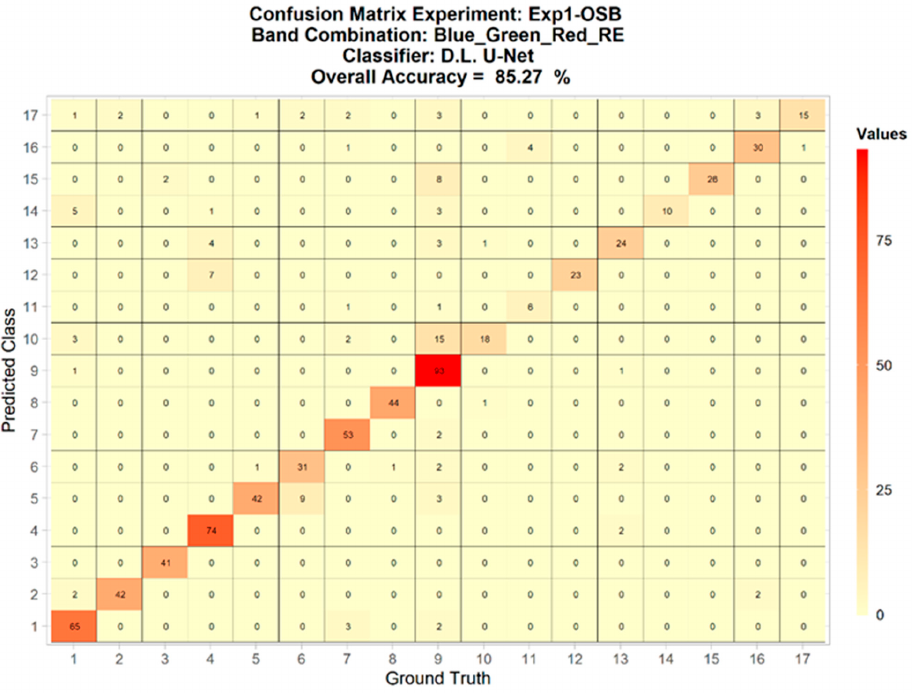
Figure A13. Confusion matrix for the best results obtained in Exp1-OSB, using the Deep Learning classifier with the U-Net architecture (the Blue_Green_Red_RE band combination).